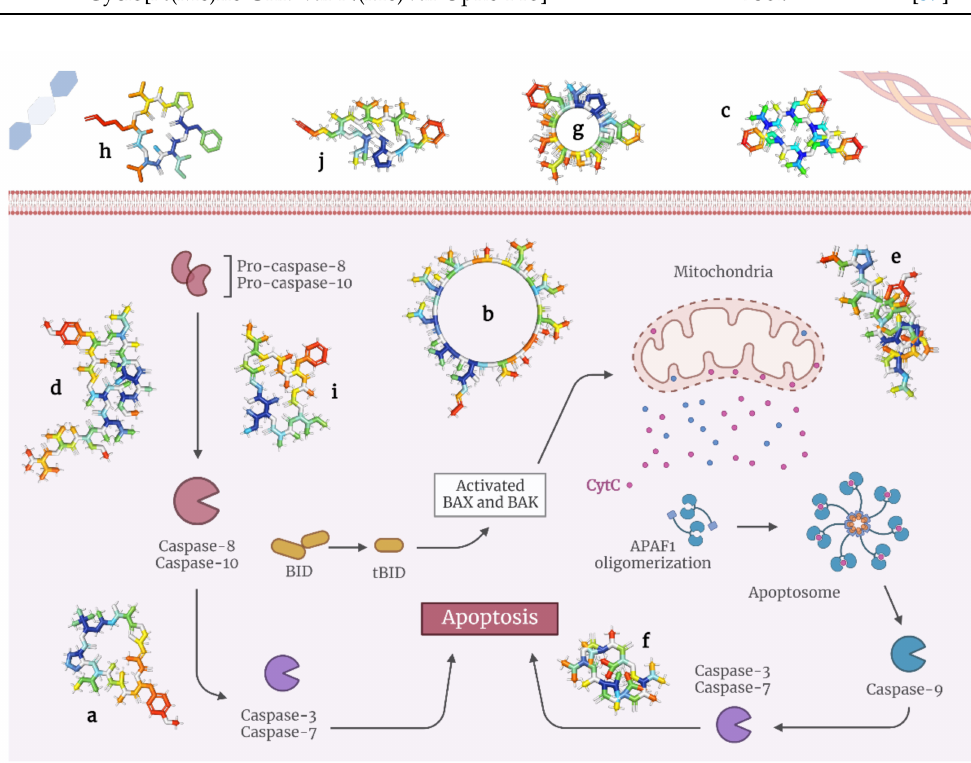
Figure 2. Models of depsipeptides inducing apoptosis in tumor cells. ( a ) Apratoxin A; ( b ) Au- rilides; ( c ) Beauvericins; ( d ) Dehydrodidemnin B; ( e ) Enniatins; ( f ) Lagunamides; ( g ) Coibamide A; ( h ) Grassypeptolides; ( i ) Hantupeptins; ( j )